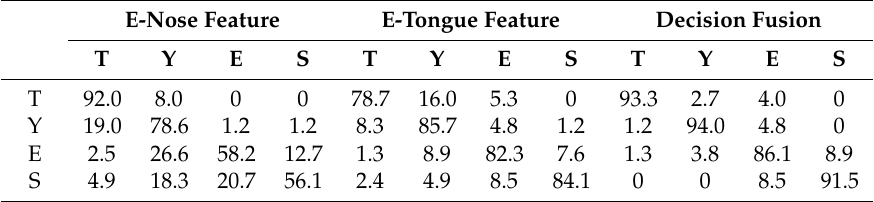
Figure 4. Recognition accuracies of the KLDA-KNN model for ( a ) E-nose ( b ) E-tongue. Table 1. Confusion matrix (%) for KLDA-KNN classification of the E-nose, E-tongue, and decision fusion.